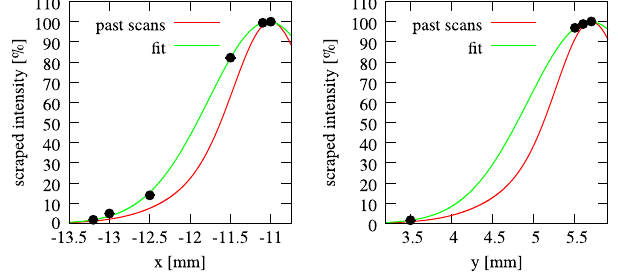
FIG. 5. Scraper scans performed before the test to determine the closed orbit at the scrapers: horizontal (left frame) and vertical (right frame) planes. The red curves are obtained from past scans [16] using emittances as measured by the WSs before the test and the centers as obtained by the scraper scans (see Table III). The green curves are the fits of Eq. (1) through the data; the fitting parameters are reported in Table IV.